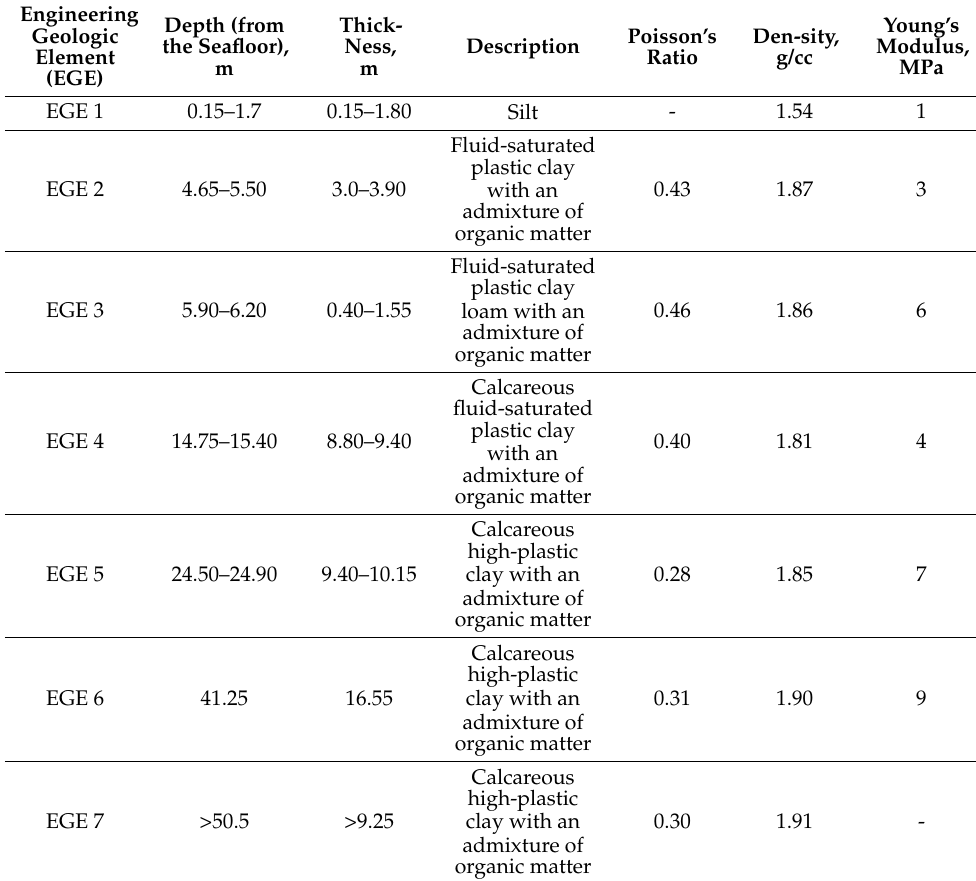
Table 1. Description of engineering geologic elements identified at the research site. The depth and thickness ranges are given according to several engineering